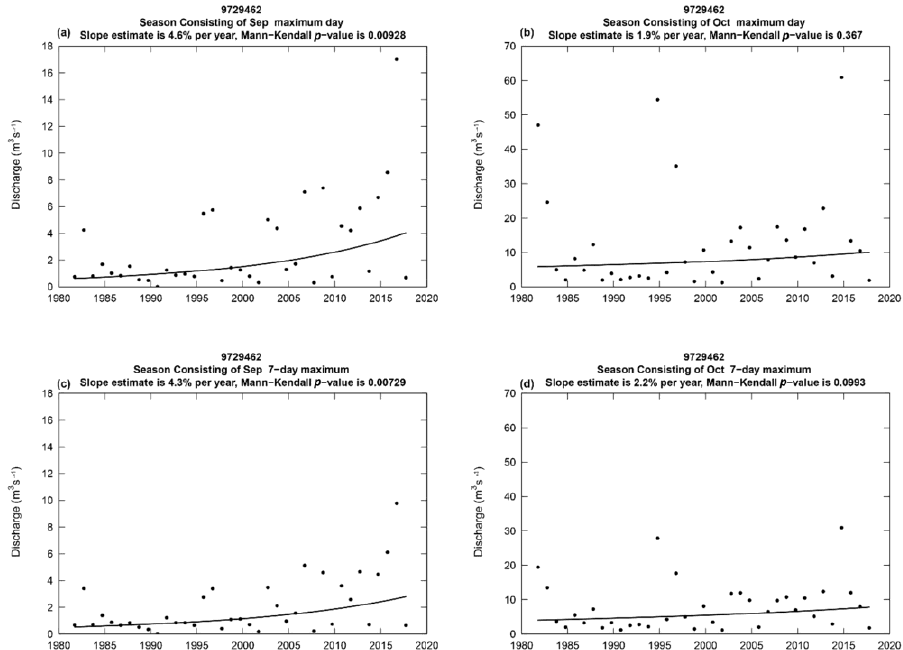
Figure A2. Trends of maximum 1-day and 7-day average discharges in the PINUP sub-basin during the period 1981 – 2017 for September ( a , c ) and October ( b , d ), respectively. A Thiel-Sen slope and a two-sided p-value for the Mann-Kendall trend test are also presented in the graphs.